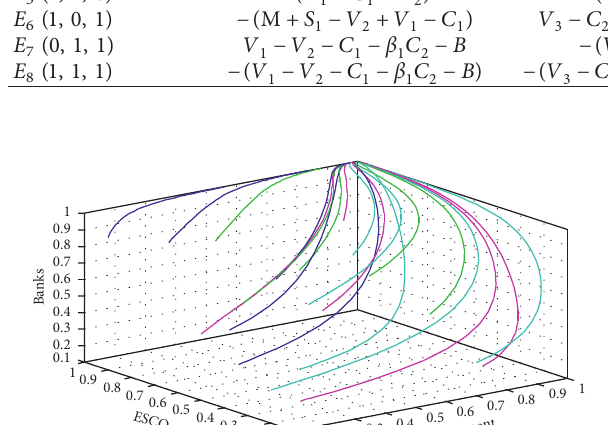
Figure 8: Government-ESCOs-banks.